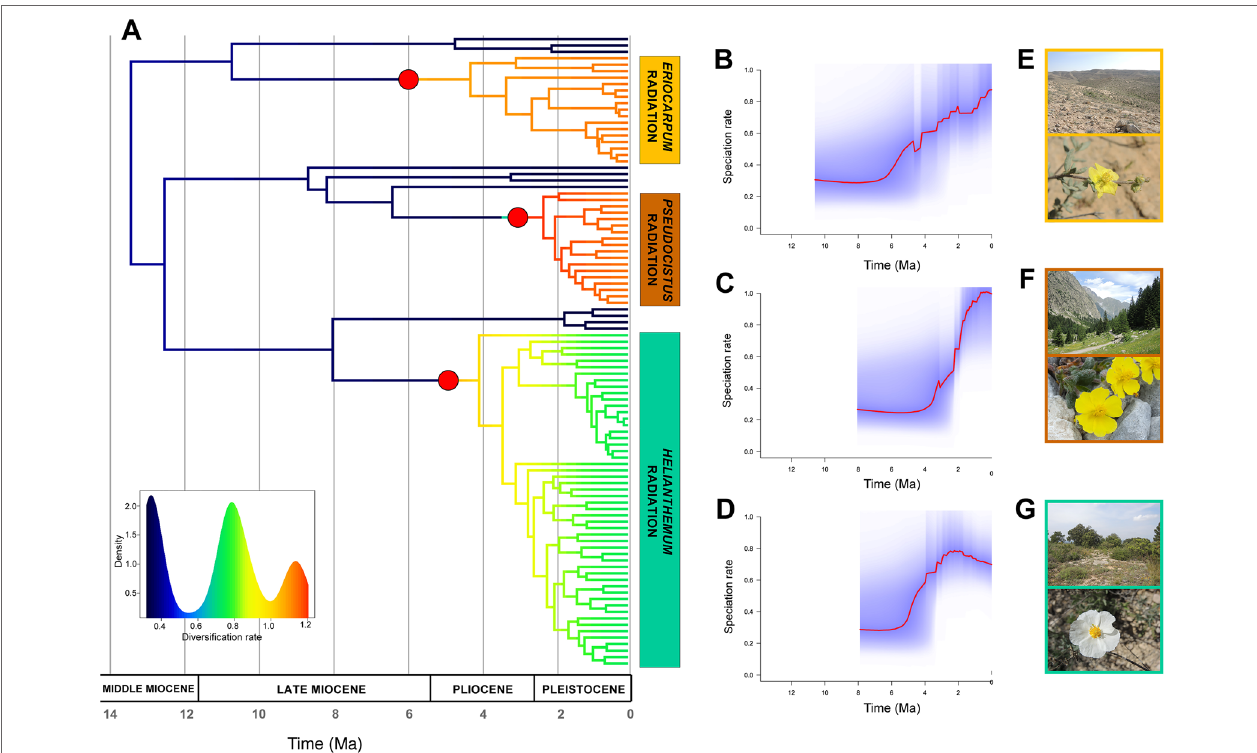
FIGURE 6 | Diversification rates in Helianthemum based on GBS data. (a) Time-calibrated phylogenetic tree obtained in TreePL from the most robust assembly (MinError configuration under 15% minimum taxon coverage), with branches coloured according to diversification rates estimated using Bayesian Analysis of The performance of the research Macroevolutionary Mixtures (BAMM). Red circles at the base of the three largest sections ( Eriocarpum s.l. , Pseudocistus and Helianthemum ) mark the three diversification rate shifts initiating three evolutionary radiations. The insert shows the density of rate values across the phylogeny. (B – D) Speciation rates over time estimated by BAMM for each radiation, starting from their respective stem nodes. (E – G) Representative species and ecosystems of the three radiations: (E) Helianthemum sessiliflorum (Desf.) Pers. in Negev Desert (Israel); (F) H. oelandicum subsp. alpestre (Jacq.) Ces. of alpine pastures in Alpes-Maritimes (France); (G) H. apenninum (L.) Miller subsp. apenninum in Mediterranean maquis at Pico Ñoño Martés